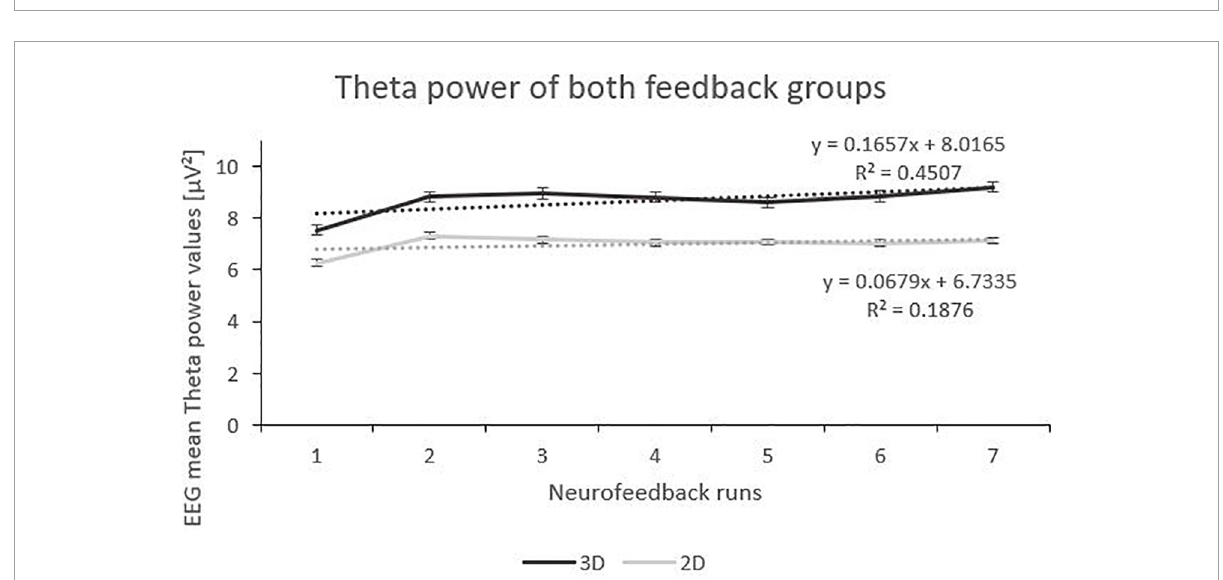
FIGURE3 Trend of Theta Power over the Feedback Runs for 3D and 2D Groups with the linear trendlines of each group. R 2 represents the respective explained variance of Theta power. Error bars show Standard